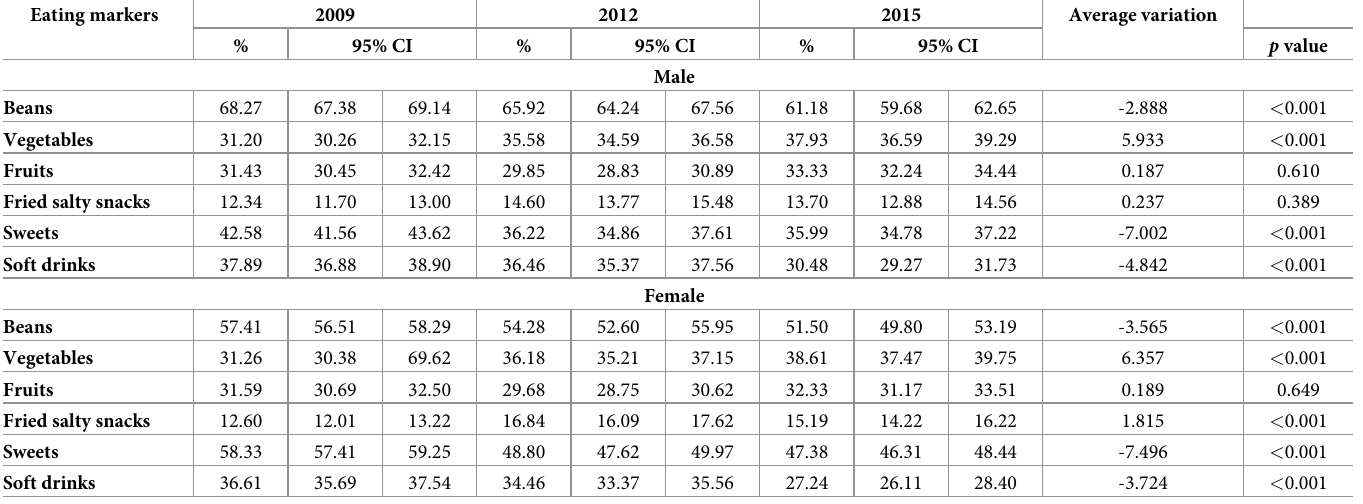
Table 3. Trends in prevalence of regular food consumption ( � 5 times/ week) of eating markers, according to gender, from 2009 to 2015. Brazil, 2009, 2012 and 2015. Eating markers